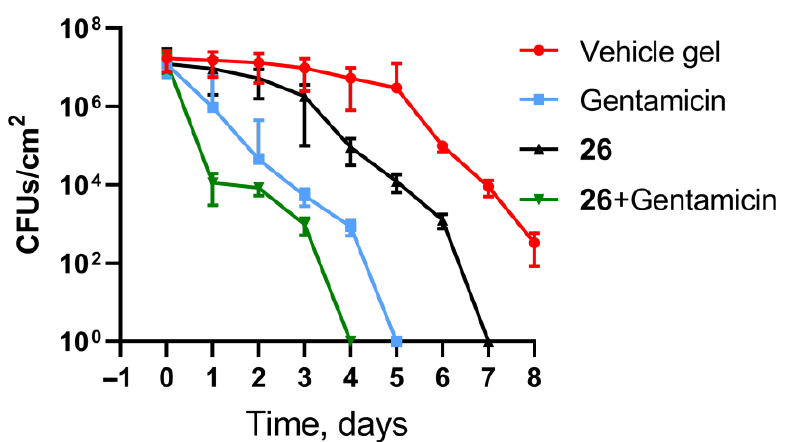
Figure 7. Count of S. aureus CFUs from the swabs of infected skin wounds of rats before and after treatment. Treatment started after 24 h of infection at day 0 of the timeline. The CFUs were counted by drop plate assay of serial dilution of bacteria from cotton swabs. The median ± IQR from five independent experiments is shown.